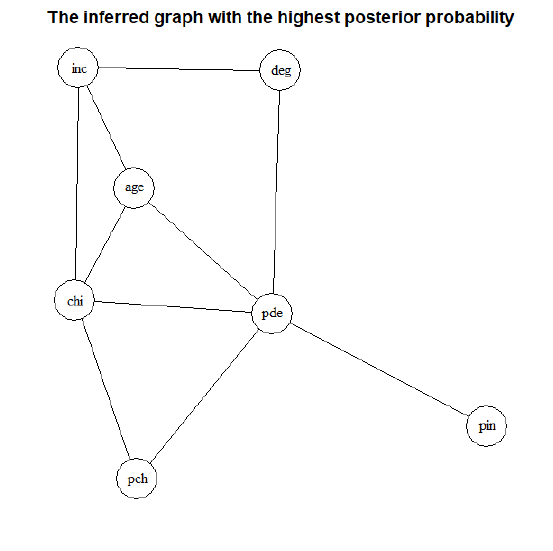
Figure 5. The figure in the left is the estimated posterior probabilities of the size of the graphs. The figure in the right is the estimated posterior probabilities of all visited graphs.